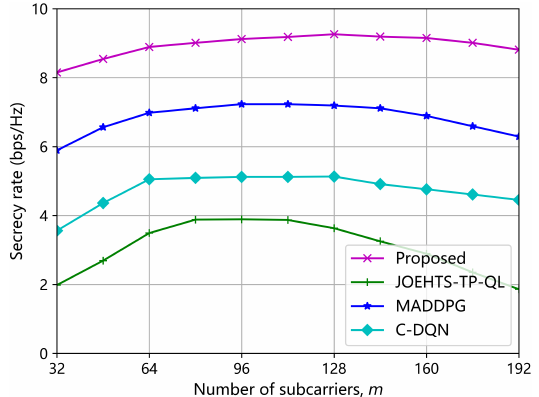
Figure 11. Secrecy rate versus the number of subcarriers m